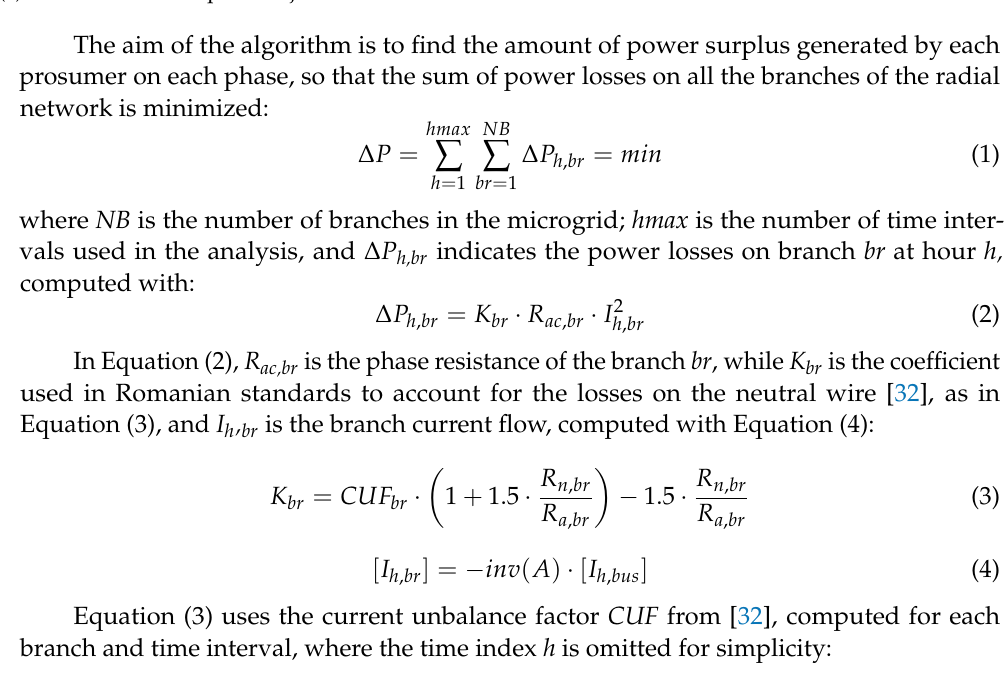
Figure 1. The approach used by the PSM algorithm for loss minimization: ( a ) unbalanced one-phase injection, ( b ) three- phase balanced injection, ( c ) unbalanced three-phase injection.